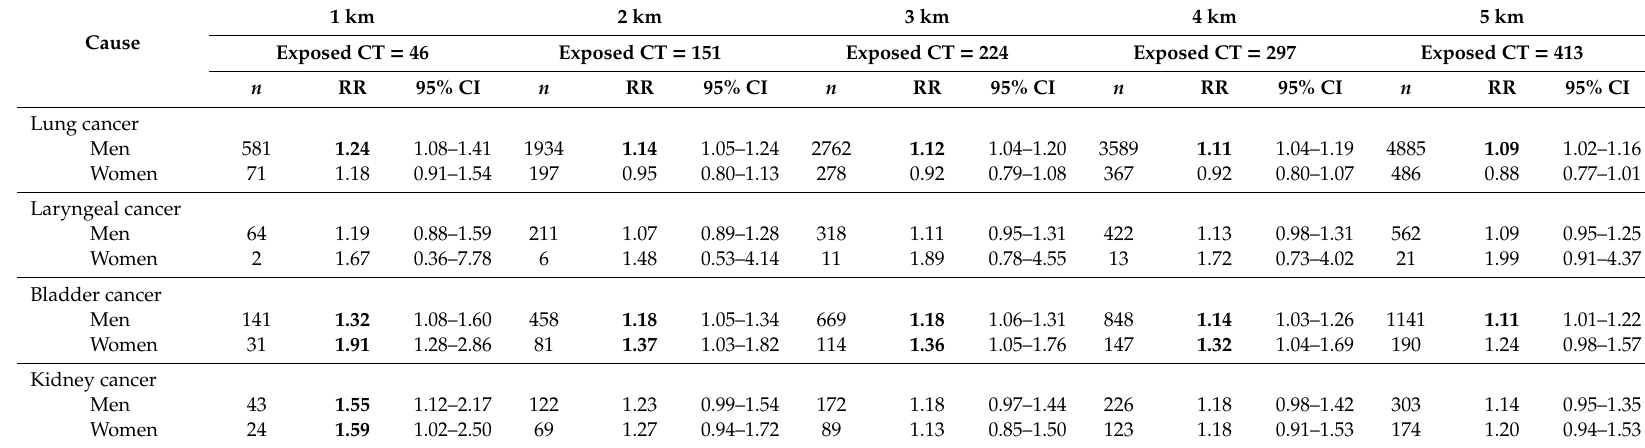
Table 3. RRs of mortality from lung, laryngeal, bladder and kidney cancers adjusted for deprivation index in census tracts situated near polluting industrial facilities. 1 km Cause